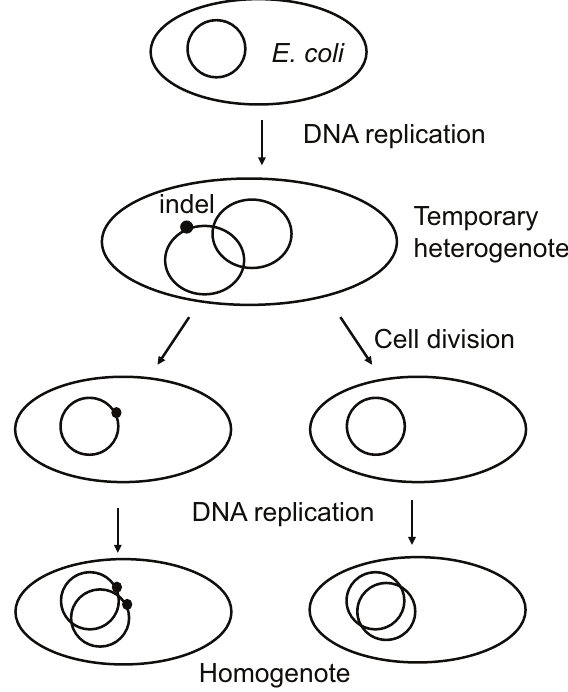
Figure 2. Indels in prokaryotes are only heterogenote for a short period of time between DNA replication and cell division. Cells have up to four copies of their genome during rapid growth. This raises the possibility that indels could be mutagenic during their attempted repair using the non-indel-containing chromosome copy. Following cell division, one of the daughter cells will possess an indel- containing chromosome, while the other daughter cell will not. The indel lineage will thereafter be homogenote for the indel. According to the previously proposed mutagenic-when-heterozygous hypothesis, the indel will not be mutagenic as it no longer exists as a heterogenote and nucleotide substitutions will not accumulate around them.